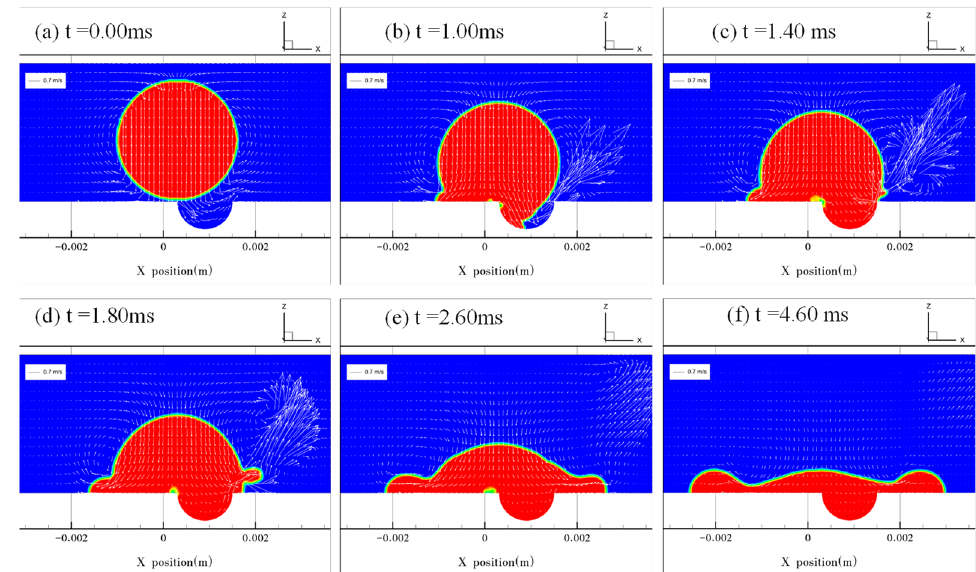
Figure 7. Droplet impacting the dimpled surface at e = 0.5. ( a ) The droplet starts to impact the surface when t = 0.00 ms. ( b ) The edge of the droplet advances along the dimpled surface. ( c , d ) The process of the droplet spreading over the dimple. Jetting is formed on the right side of the droplet. ( e ) The diminishing of jetting due to the surface tension force. ( f ) The droplet reaches its maximum spreading diameter.